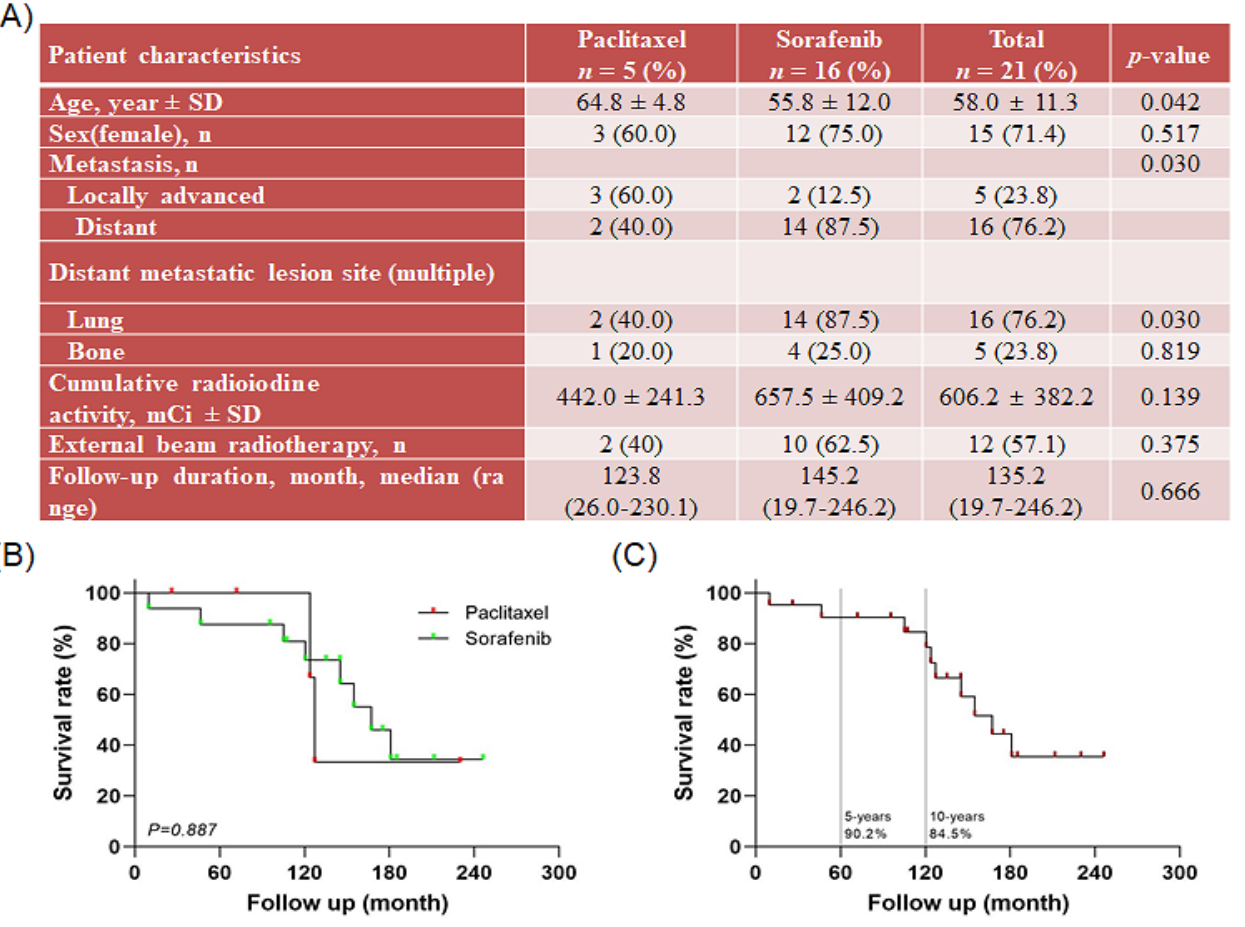
Figure 1. Information on patients with papillary thyroid carcinoma (PTC) after treatment with paclitaxel and sorafenib: ( A ) patient characteristics and clinical features, ( B ) overall survival rate after treatment with paclitaxel and sorafenib, and ( C ) overall survival rate of patients with refractory PTC.